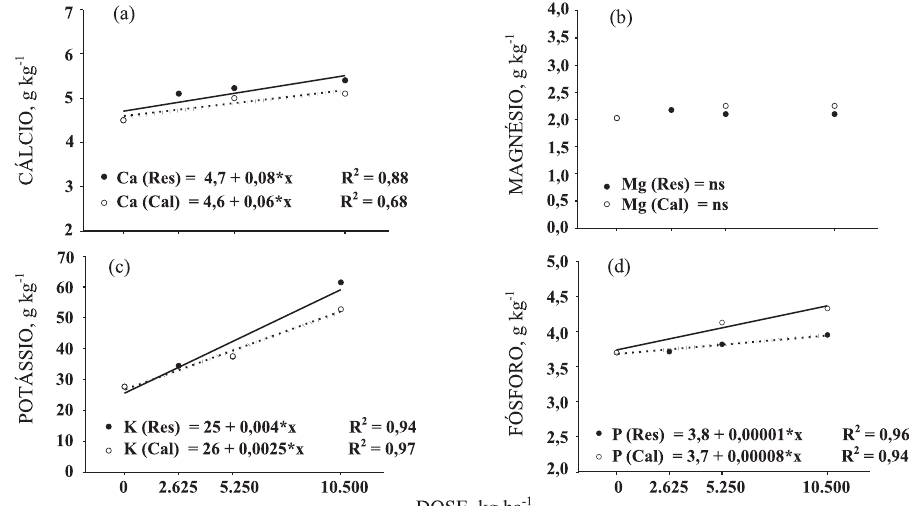
Figura 4. Teores de cálcio (a), magnésio (b), potássio (c) e fósforo (d) no tecido da parte aérea de plantas de trigo no início do florescimento, cultivadas em um Cambissolo Húmico alumínico corrigido com doses de resíduo alcalino (Res) e calcário (Cal), aplicadas em superfície, calculadas com base no método SMP (*, ** e ns: significativo a 5 e 1 % e não